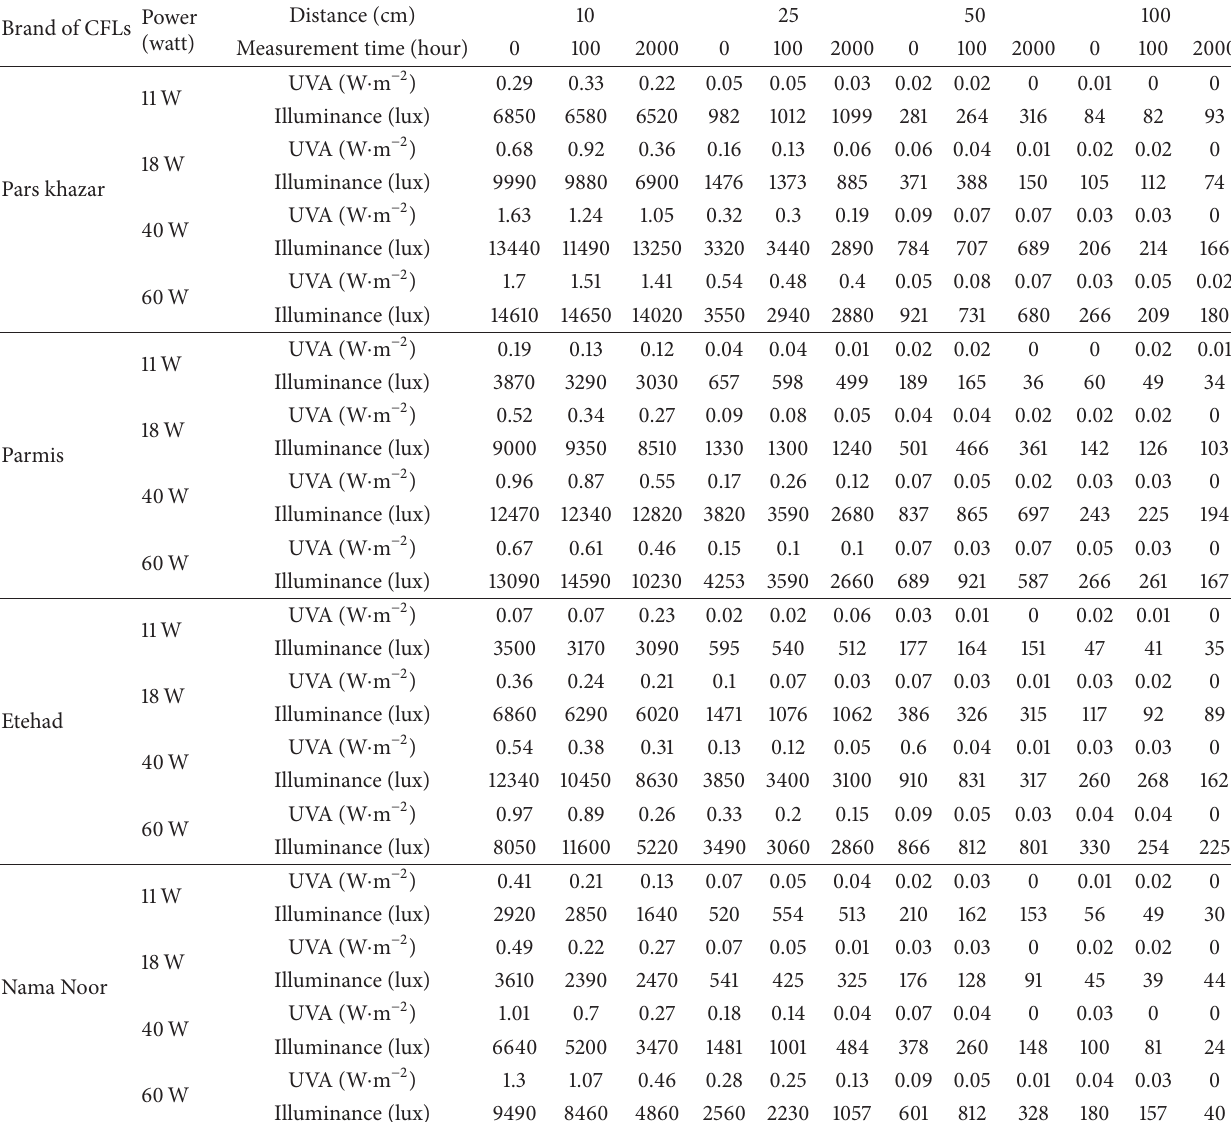
Table 2: UVA irradiance (W ⋅ m −2 ) and illuminance (lux) in different times for four brand CFLs in Iranian brands. Power Brand of CFLs